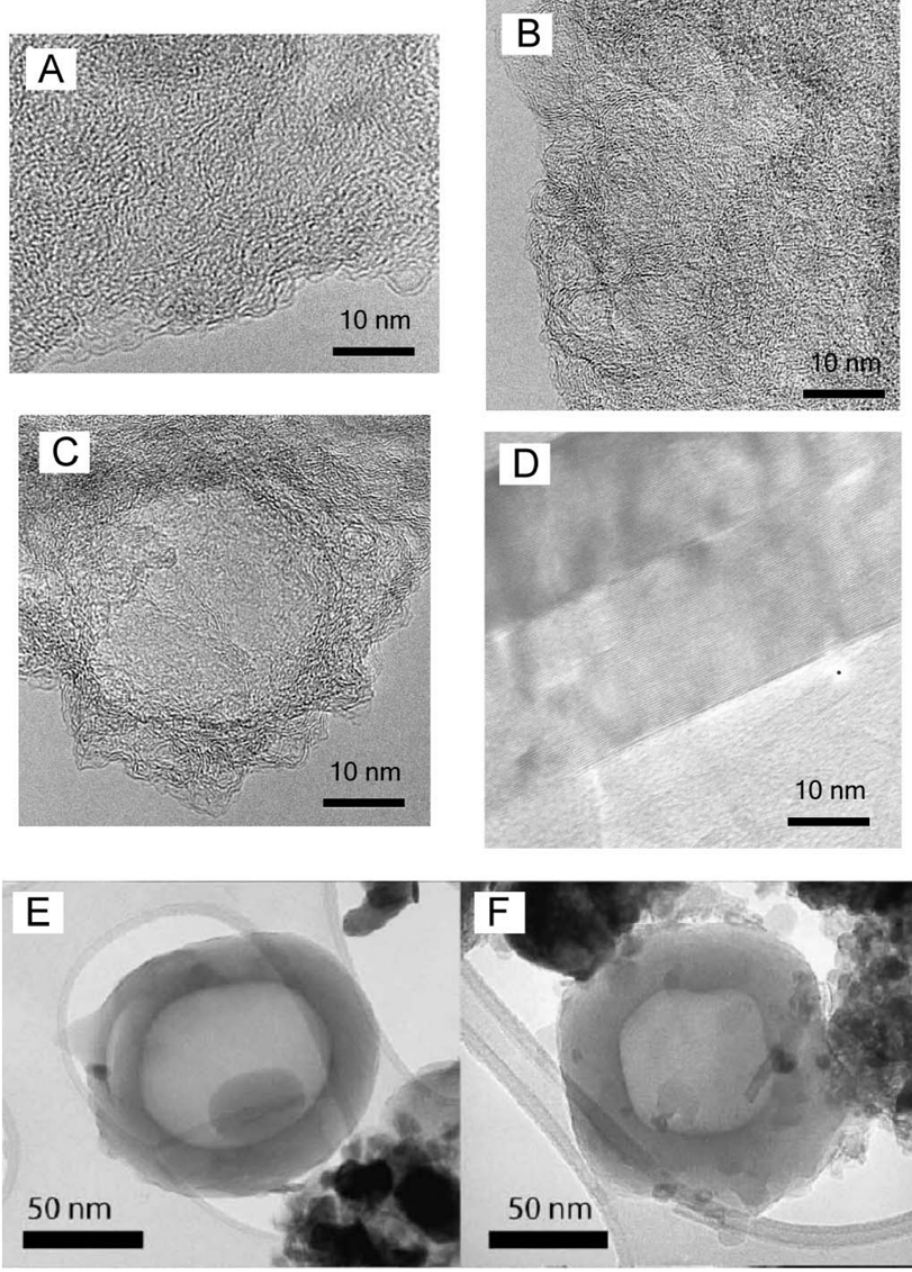
Figure 6. HRTEM images of various textures of carbonaceous material in chondrites. IOM usually shows a disorganized structure (A: Murchison, B: Kainsaz). Aromatic layers are curved and do not defined large coherent domains. With temperature increase, the organization improves slightly (compare A and B), with an increase in the size of aromatic layers, and a reducing of the interlayer spacing. In reduced conditions or/and under pressure, the organic matter will end to graphite (D, in Kansaz). In general, the structure exhibits important porosity (C: Kainsaz). In a lot of CM, CR and CI, nanoglobules have been observed (E in Tagish Lake and F in Mighei; from [98]).